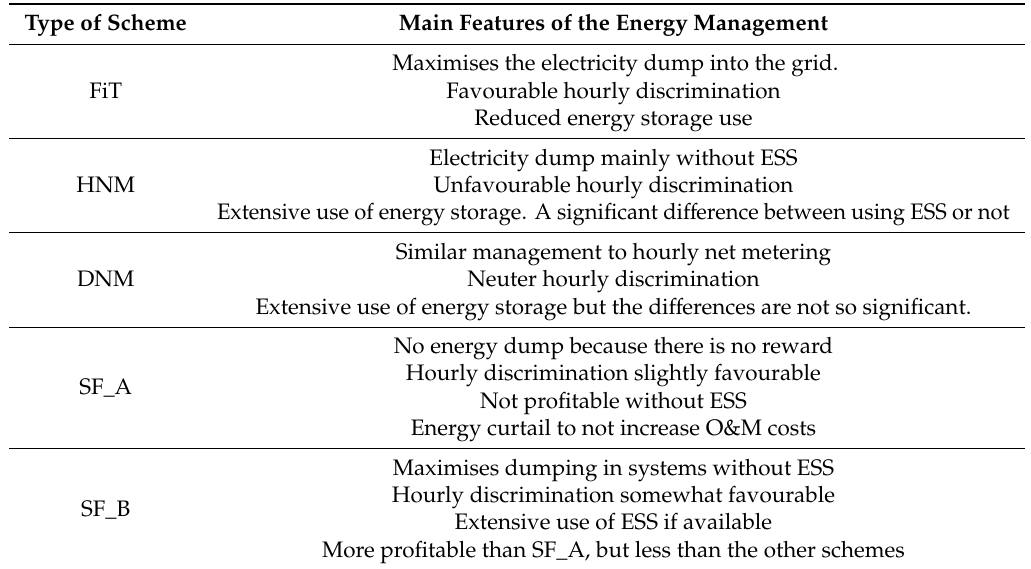
Table 6. Summary of the di ff erences in energy management under di ff erent regulatory schemes. Type of Scheme